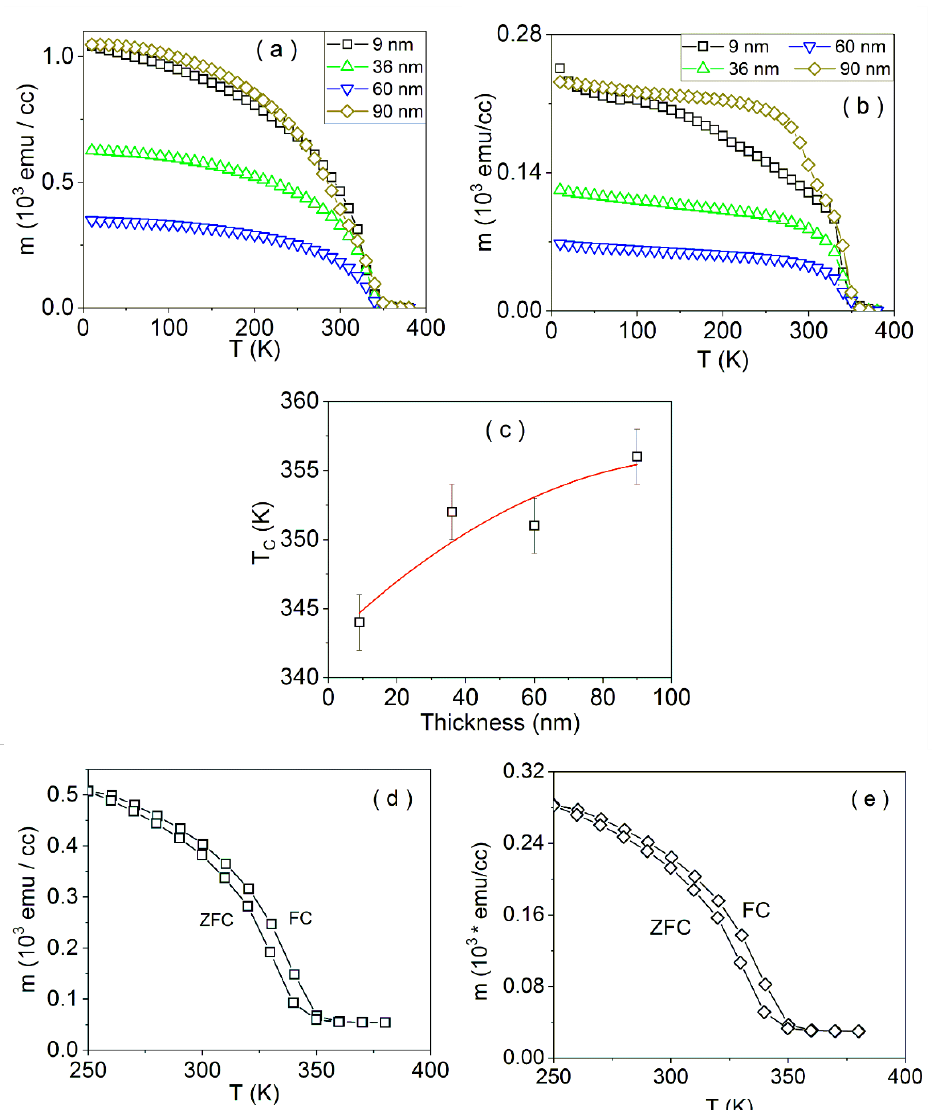
Figure 3. The temperature dependence of the magnetic moment per unit volume, in parallel ( a ) and perpendicular ( b ) geometry, in a cooling field ( H FC ) of 1 kOe, for the LSMO samples. Curie temperature for the LSMO samples ( c ); the line connecting the experimental points is only for guidance. ZFC-FC curves of samples LSMO 36 ( d ) and LSMO 60 ( e ), with field cooling at 500 Oe, in the parallel geometry.